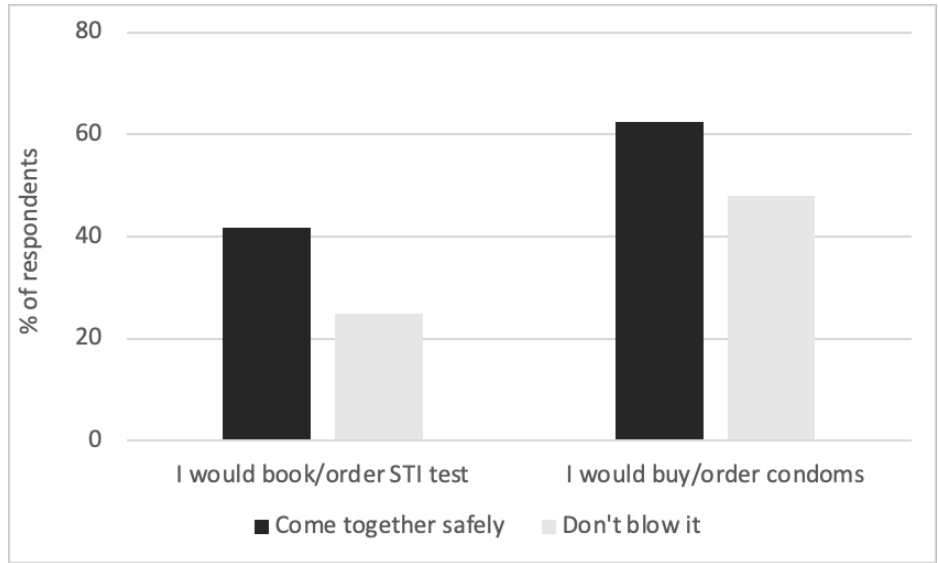
Figure 1. Percentage of respondents who reported an intention to perform the target behaviours— either buying or ordering condoms or STI tests—after seeing each campaign.